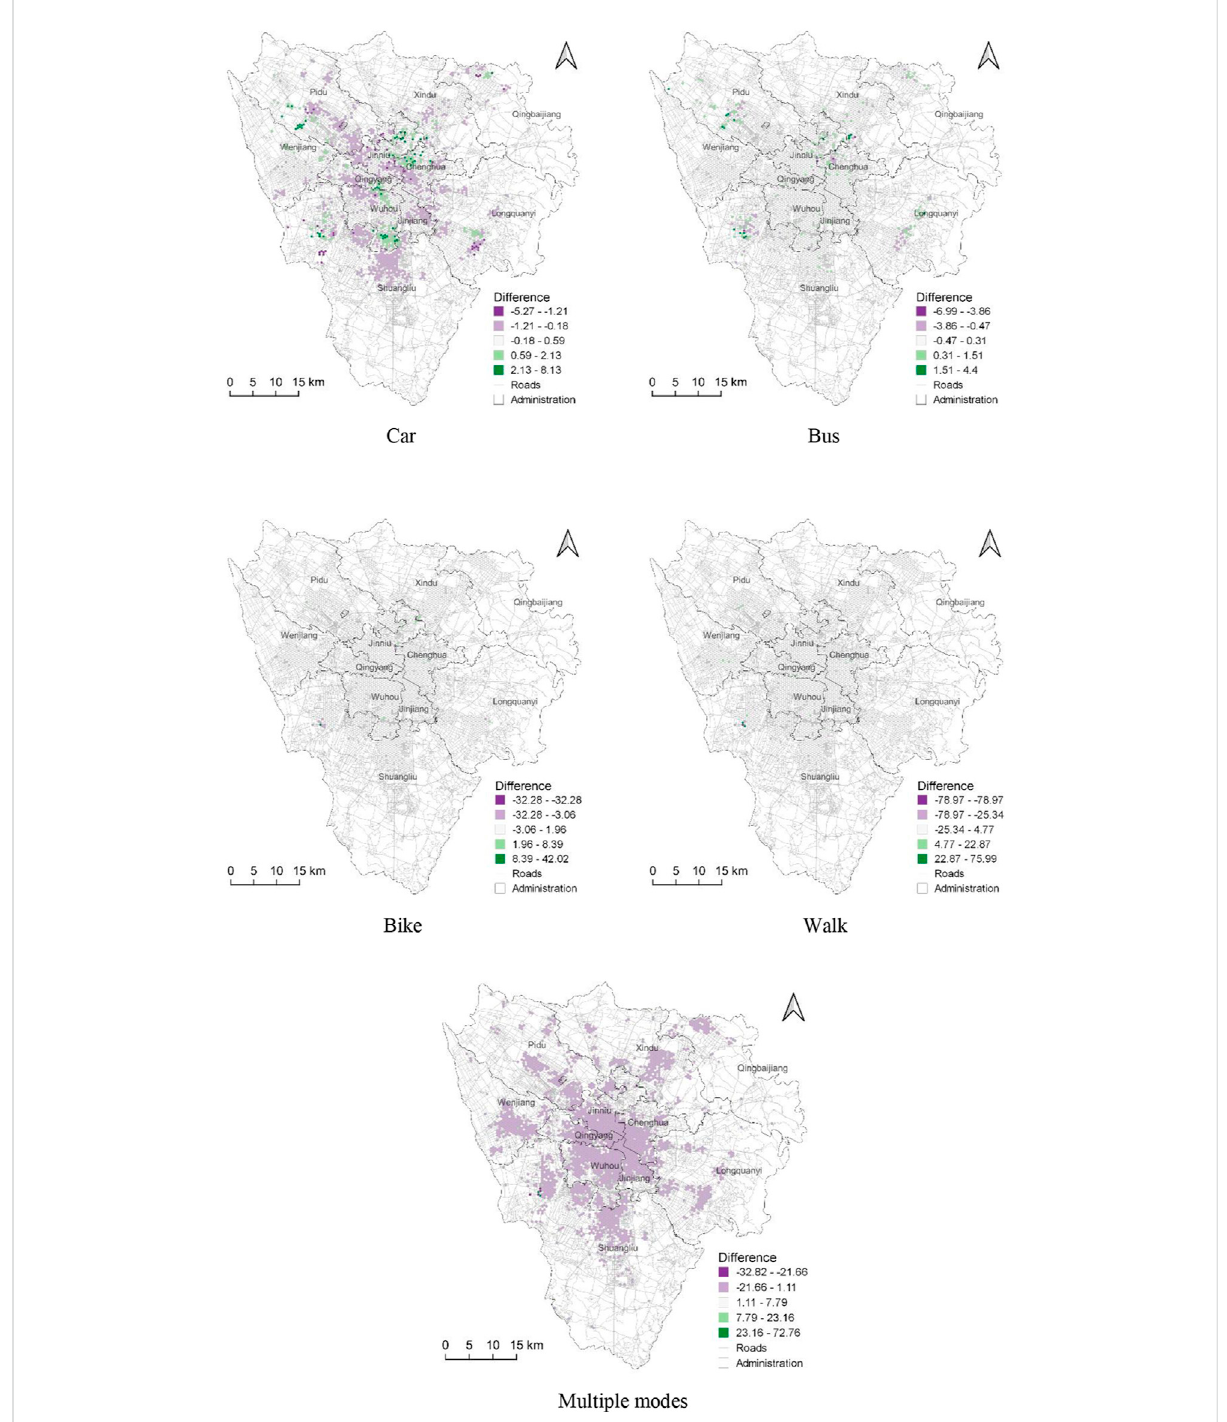
FIGURE 7 Difference of park accessibility by four travel modes between the peak period and non-peak